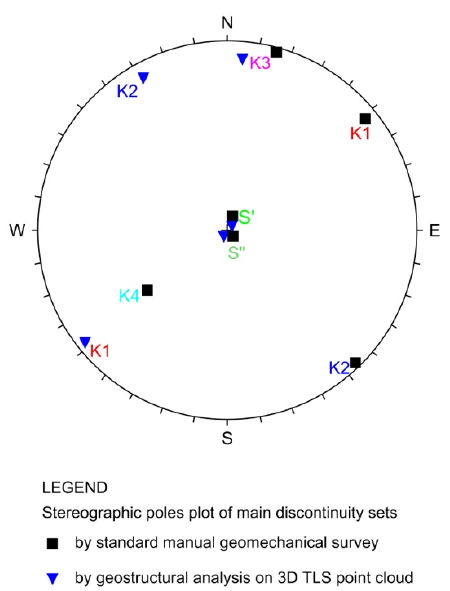
Figure 15. Stereoplot showing the comparison among the data from geo-structural analysis from point cloud and direct acquisition from standard geomechanical survey.